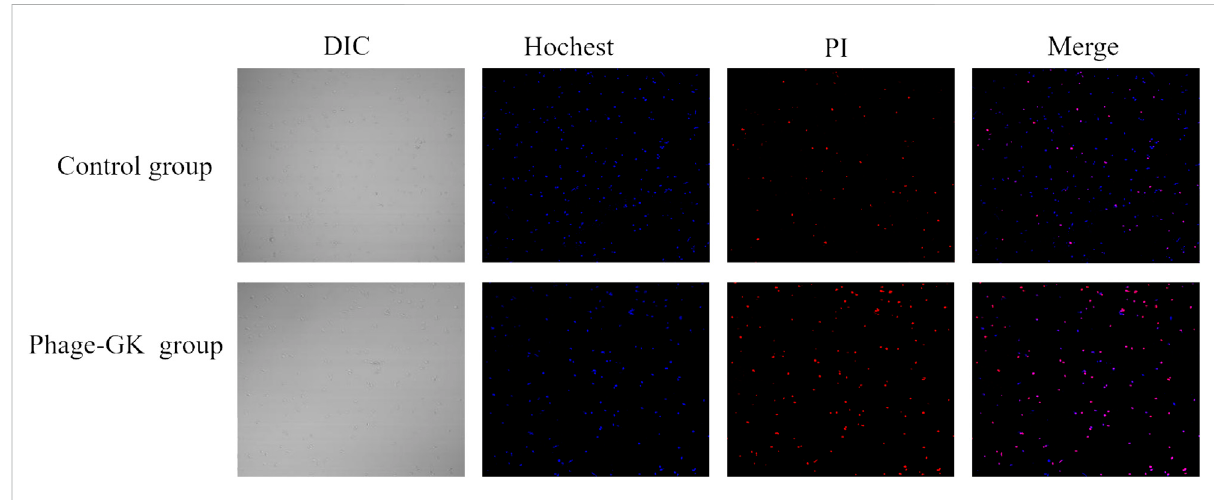
FIGURE 3 Necrosis and apoptosis of S. globosa cells after PG treatment observed using confocal laser scanning microscopy after Hoechst/PI